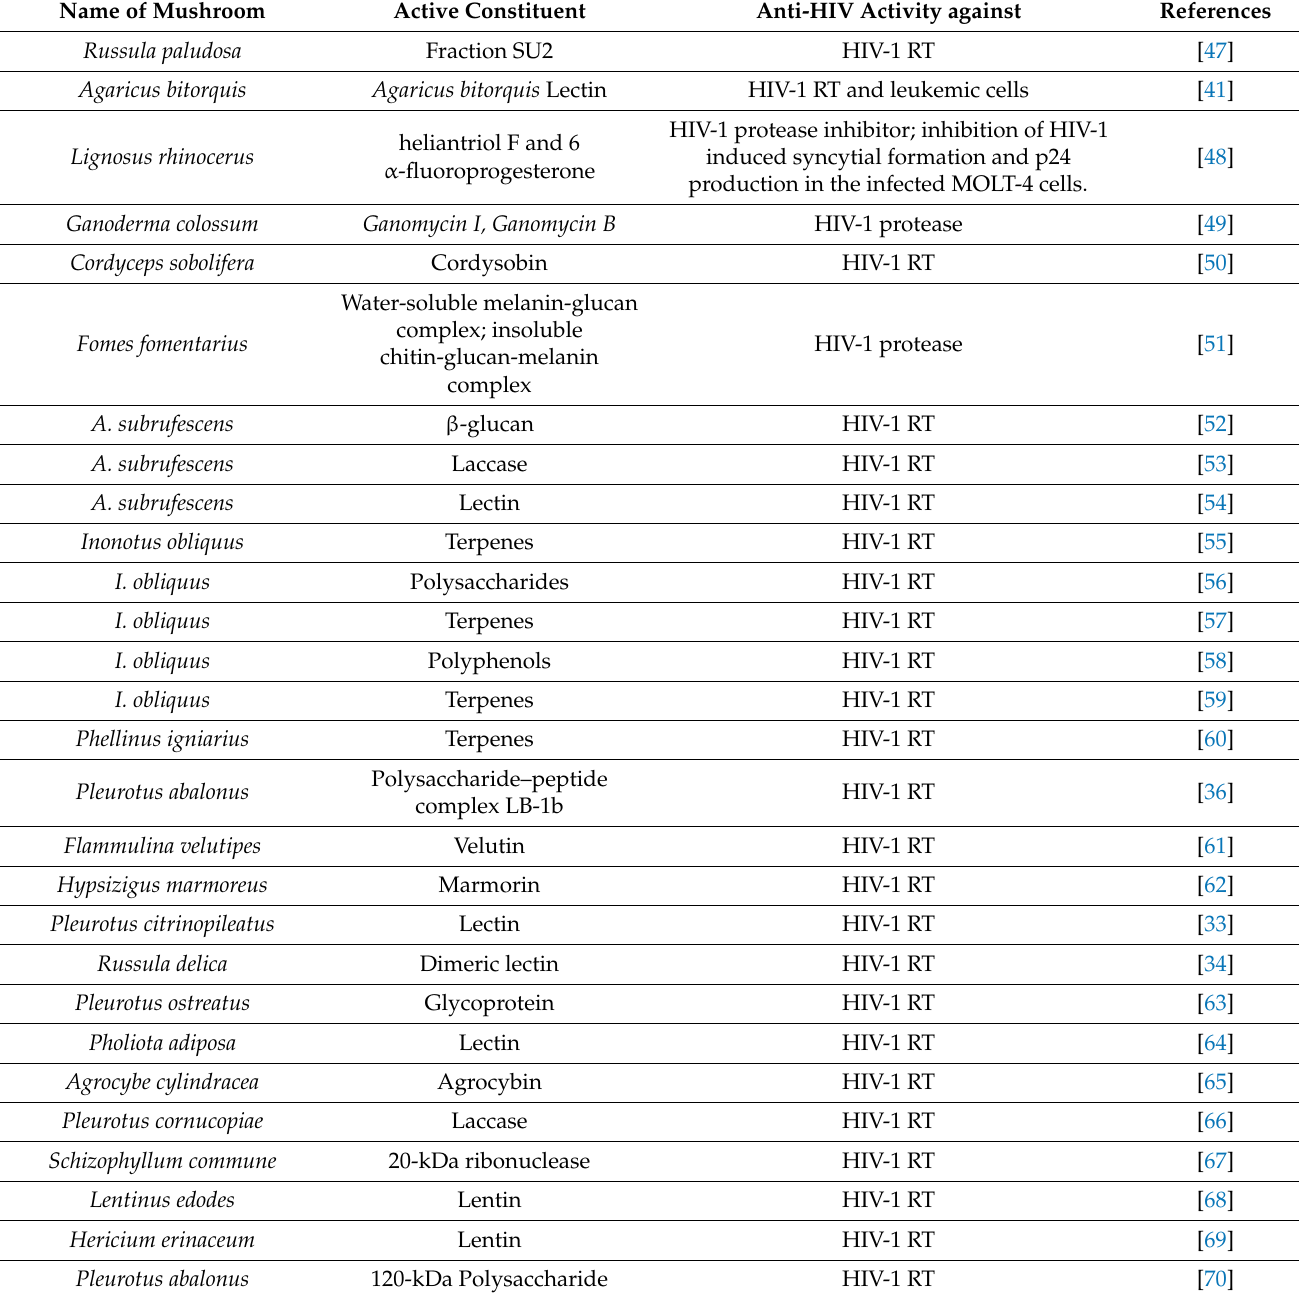
Table 2. Mushrooms and their active constituents for the